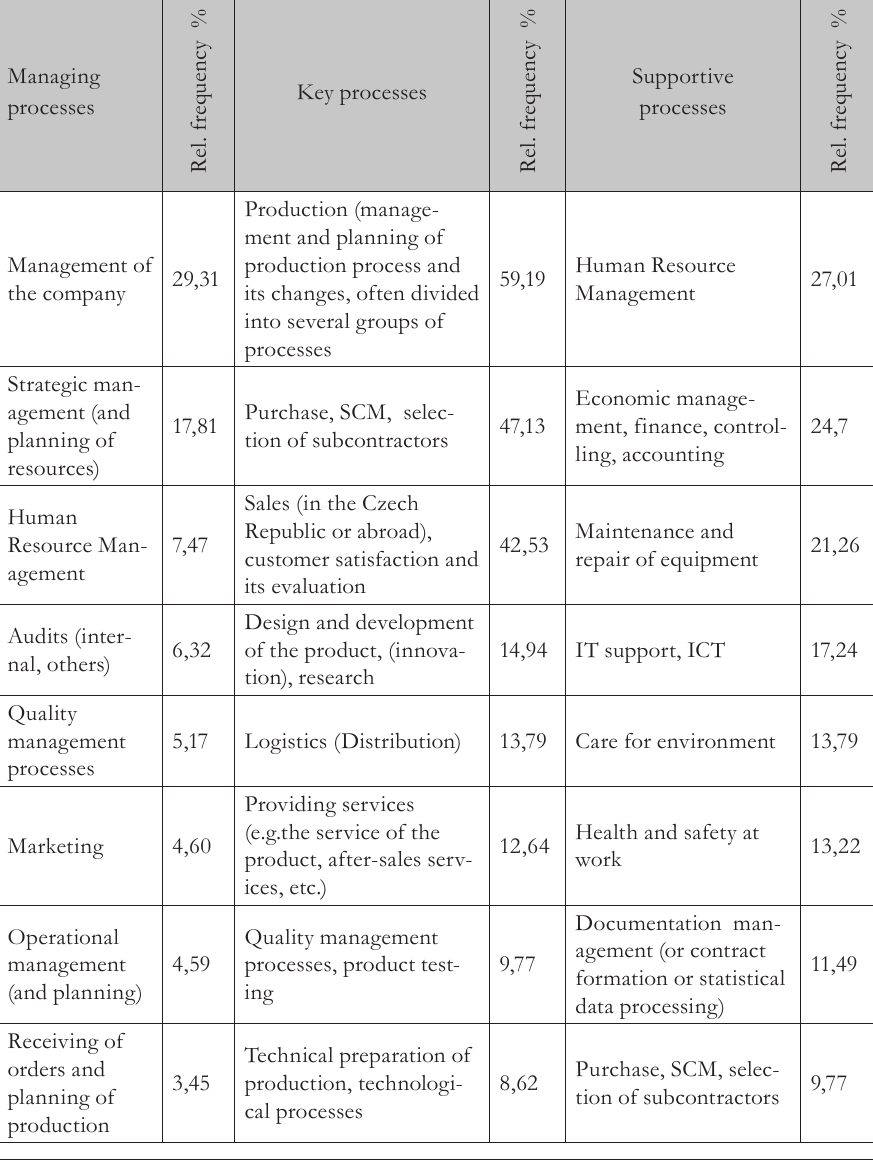
Tab. 1 – Classification of groups of processes in companies presented as: managing, key and supportive in 2006 and in 2013. Source: own